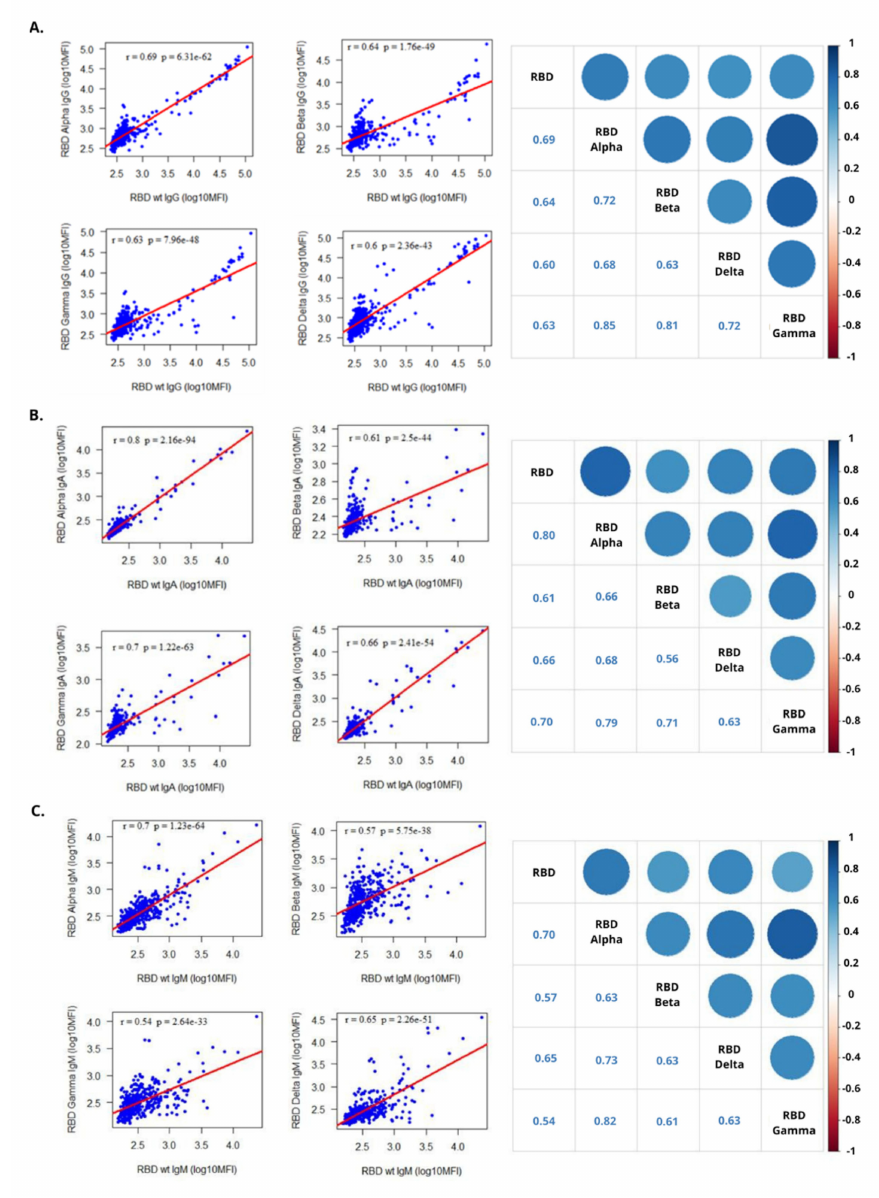
Figure 3. Correlation analysis using Spearman’s coefficient between Wuhan RBD and the RBDs of the different SARS-CoV-2 VoCs (Alpha, Beta, Gamma, and Delta) for each isotype: ( A ) IgG, ( B ) IgA, and ( C )